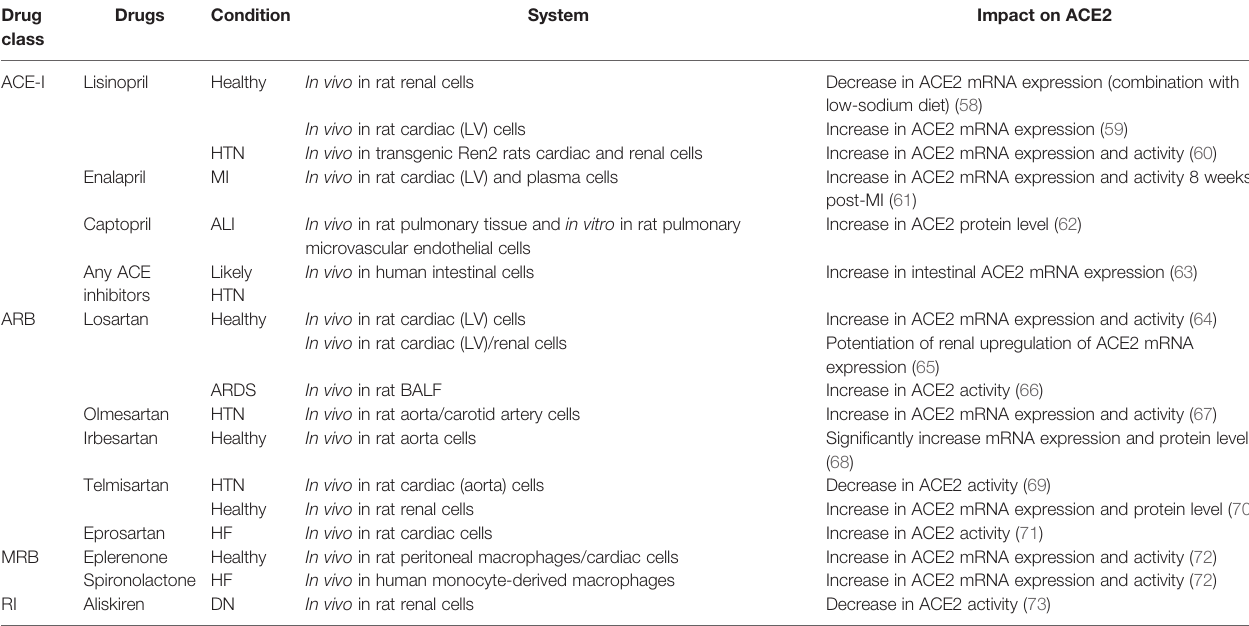
TABLE 2 | Studies investigating the impacts of several cardiopulmonary diseases and renin – angiotensin system modulators on angiotensin-converting enzyme 2 expression and activity. Drug